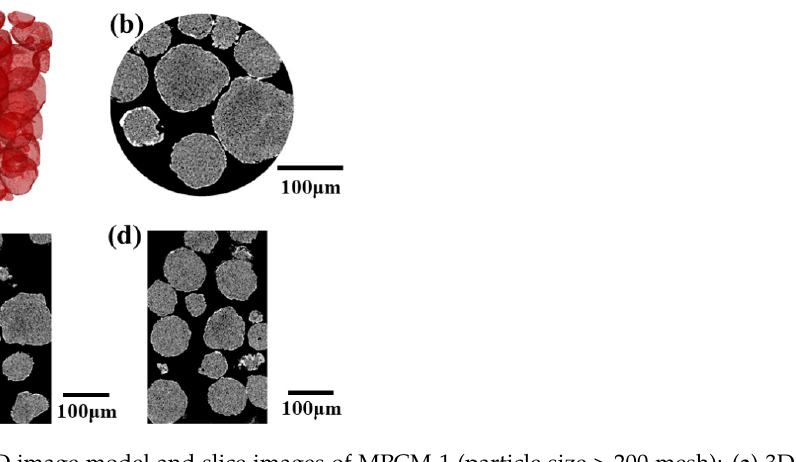
Figure 6. 3D image model and slice images of MPCM-1 (particle size > 200 mesh): ( a ) 3D image models, ( b ) XY plane slice, ( c ) YZ plane slice, and ( d ) XZ plane slice.